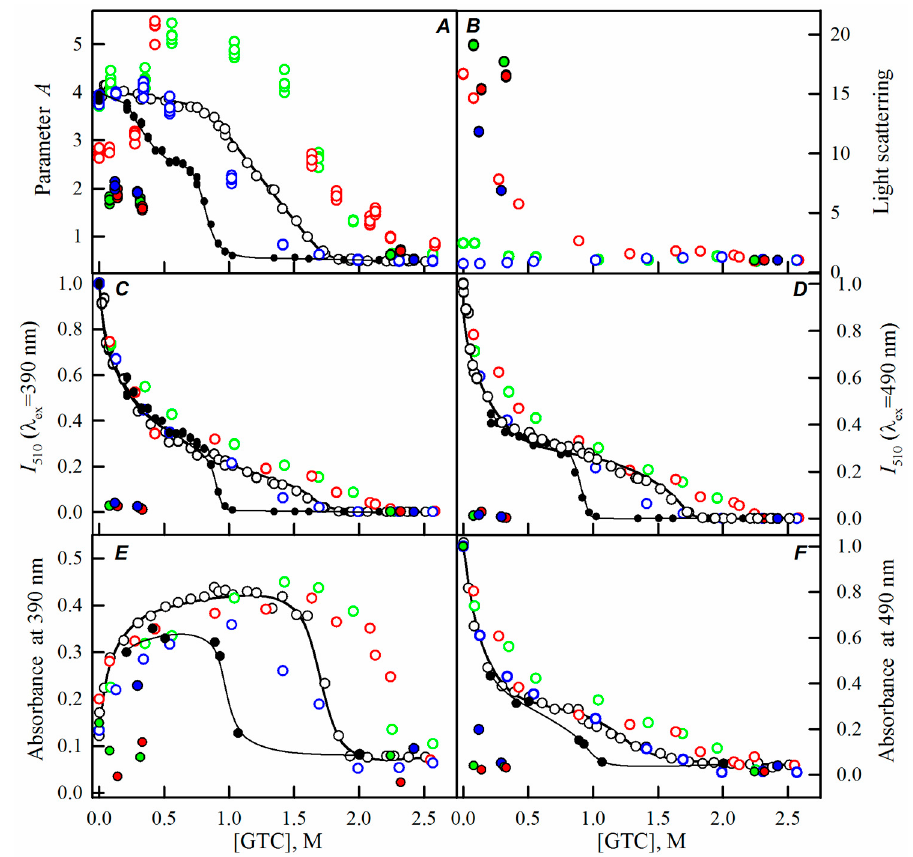
Figure 2. The effect of crowding agent PEG-12000 on the sfGFP conformational changes induced by GTC. Changes of parameter A ( A ); light scattering ( B ); corrected fluorescence intensity of green chromophore at two wavelengths of excitation of 390 nm ( C ) and 490 nm ( D ); and changes of absorbance at 390 nm ( E ) and 490 nm ( F ) are shown. Open symbols indicate unfolding and filled symbols represent refolding. Measurements were performed after 24 h incubation of native or denatured protein in the presence of GTC or GTC and the crowding agent. The applied concentrations of PEG-12000 were 8% (blue circles), 20% (green circles), and 30% (red circles). The unfolding-refolding curves of sfGFP in the absence of the crowding agent are also shown (black circles and lines).